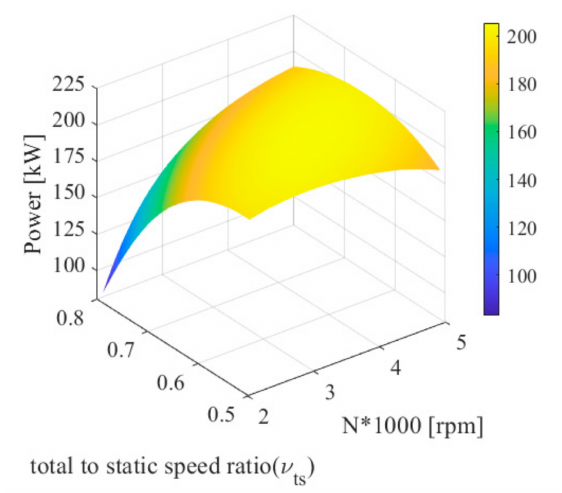
Figure 9. Variation of the power with the total to static speed ratio and rotor RPM.